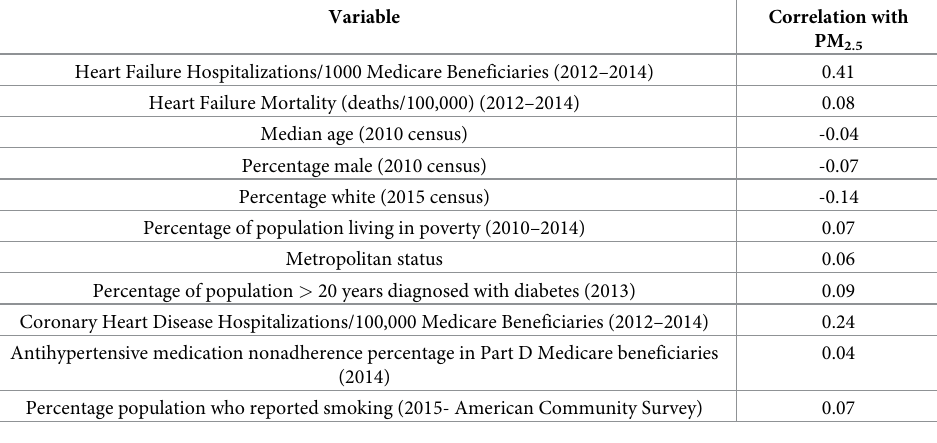
Table 2. Correlation of county PM 2.5 concentration levels with outcomes and covariates.